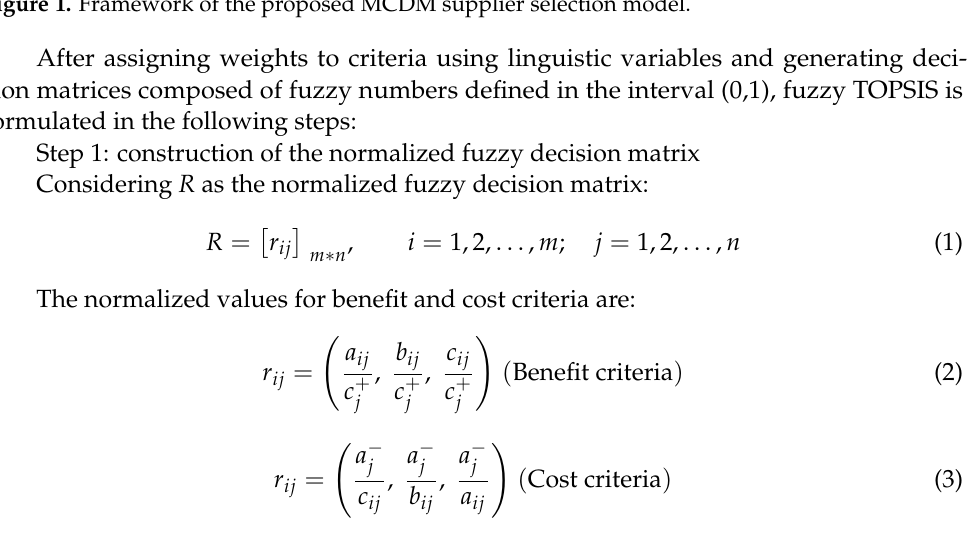
Figure 1. Framework of the proposed MCDM supplier selection model.